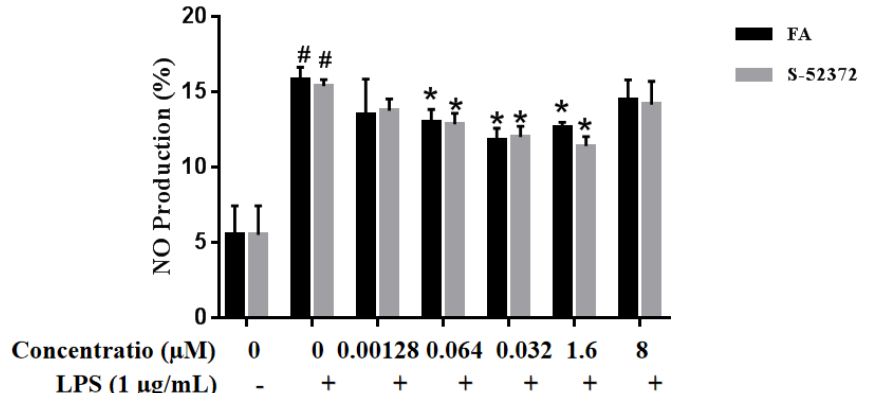
Figure 6. Inhibition of the FA and S-52372 on LPS-induced nitric oxide (NO) in RAW 264.7 macro- phages. Each bar illustrates the average ± standard deviation (SD) counted from three experiments. * p < 0.05 compared to the only LPS − treated group; # p < 0.05 compared to the control group.